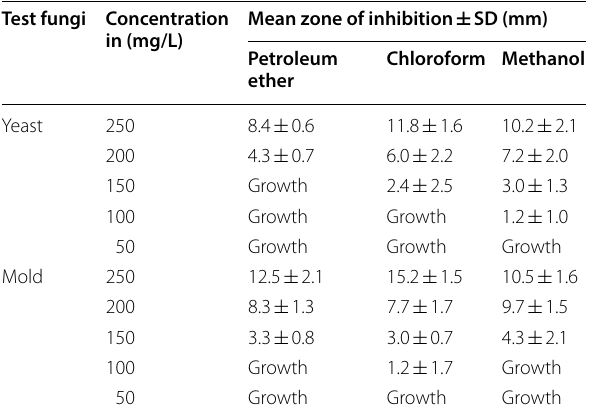
Values are expressed in mean The word “growth” represents zero inhibition zone the extract at a given concentration